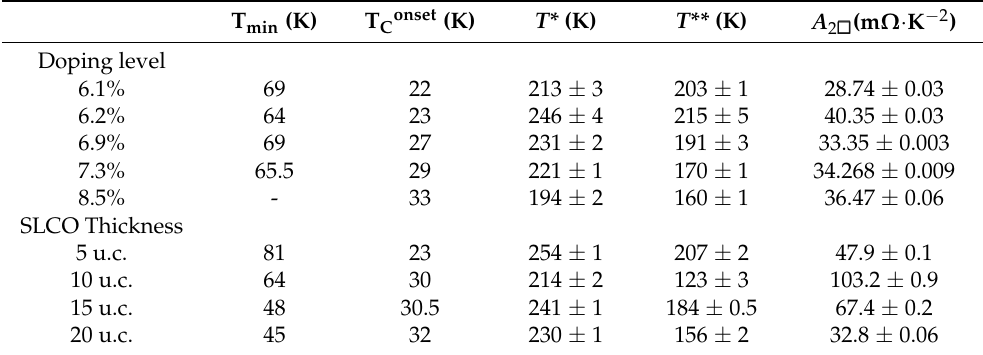
Table 1. : T min , T Conset , T* , T** and A 2 (cid:3) values obtained from resistivity measurements for each of the examined